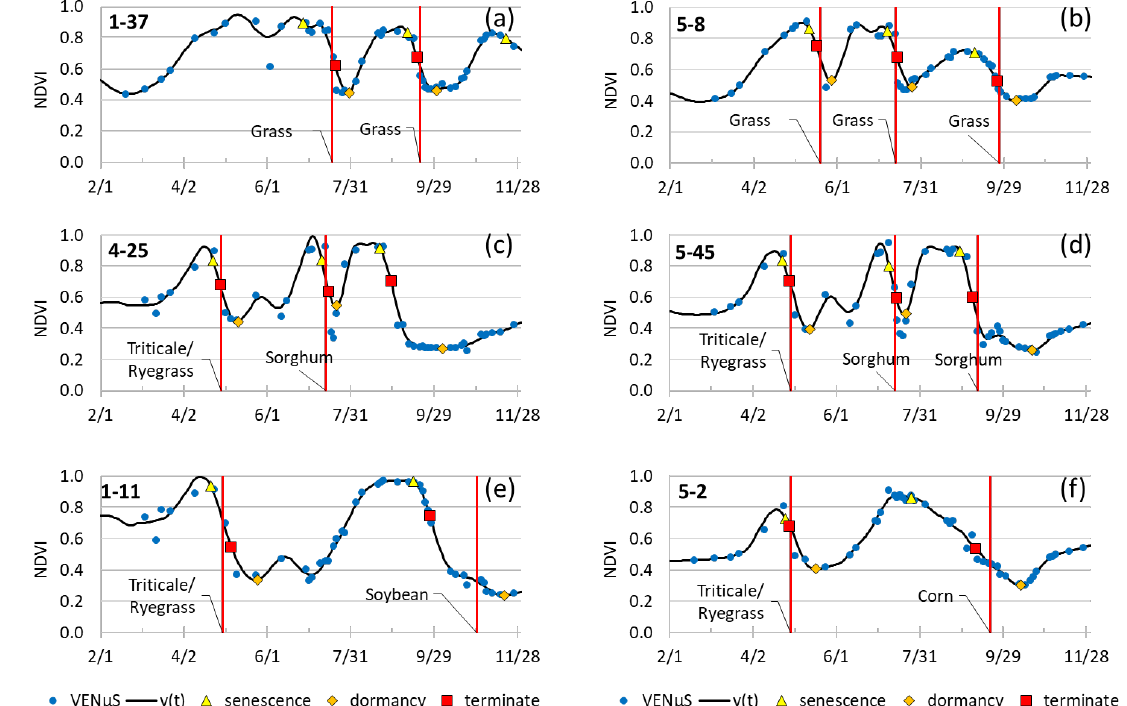
Figure 7. Detected termination dates (red squares) from the VENµS time-series and the recorded harvest operation (vertical red lines) for six typical fields (( a – f ), field name in the upper left) at the BARC with cover crops.